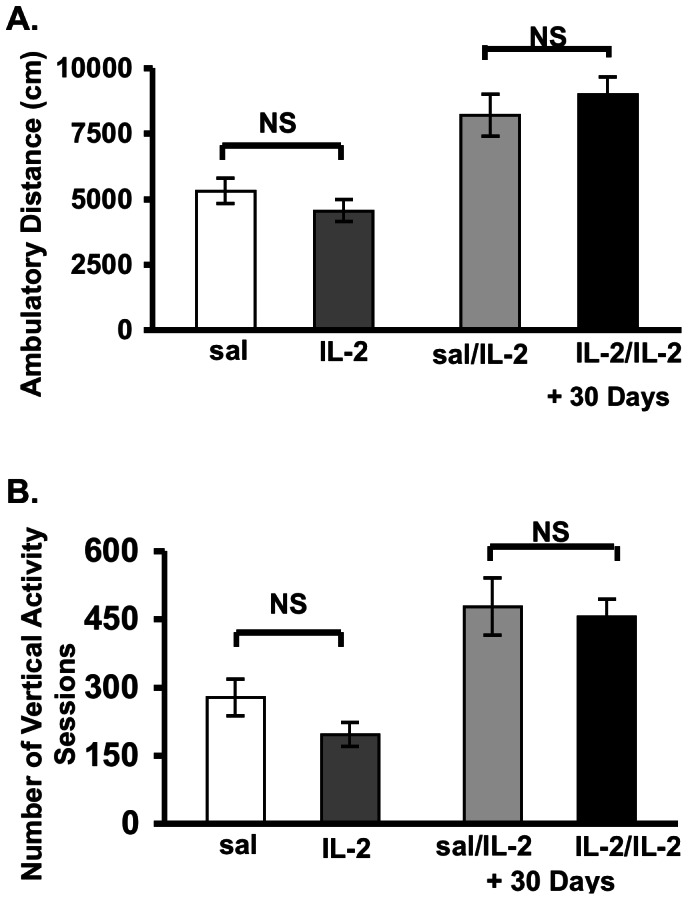
Administration of a single injection of IL-2 in periadolescent mice does not alter other motor responses (i.e. ambulatory distance or vertical activity), in contrast to the modulatory effects upon rearing shown in Figure 2.A second injection of IL-2 30-days later also did not alter these responses. Mean (± S.E.M.) activity scores ((A). Ambulatory distance (cm); (B). Number of vertical activity sessions) following a single injection of saline or IL-2 (0.4 µg/mouse, s.c.) and those tested 30 days later with single injection of IL-2 (0.4 µg/mouse, s.c.), as described in figure with “+30 days” designation. p>0.05 NS [NS = non-significance].